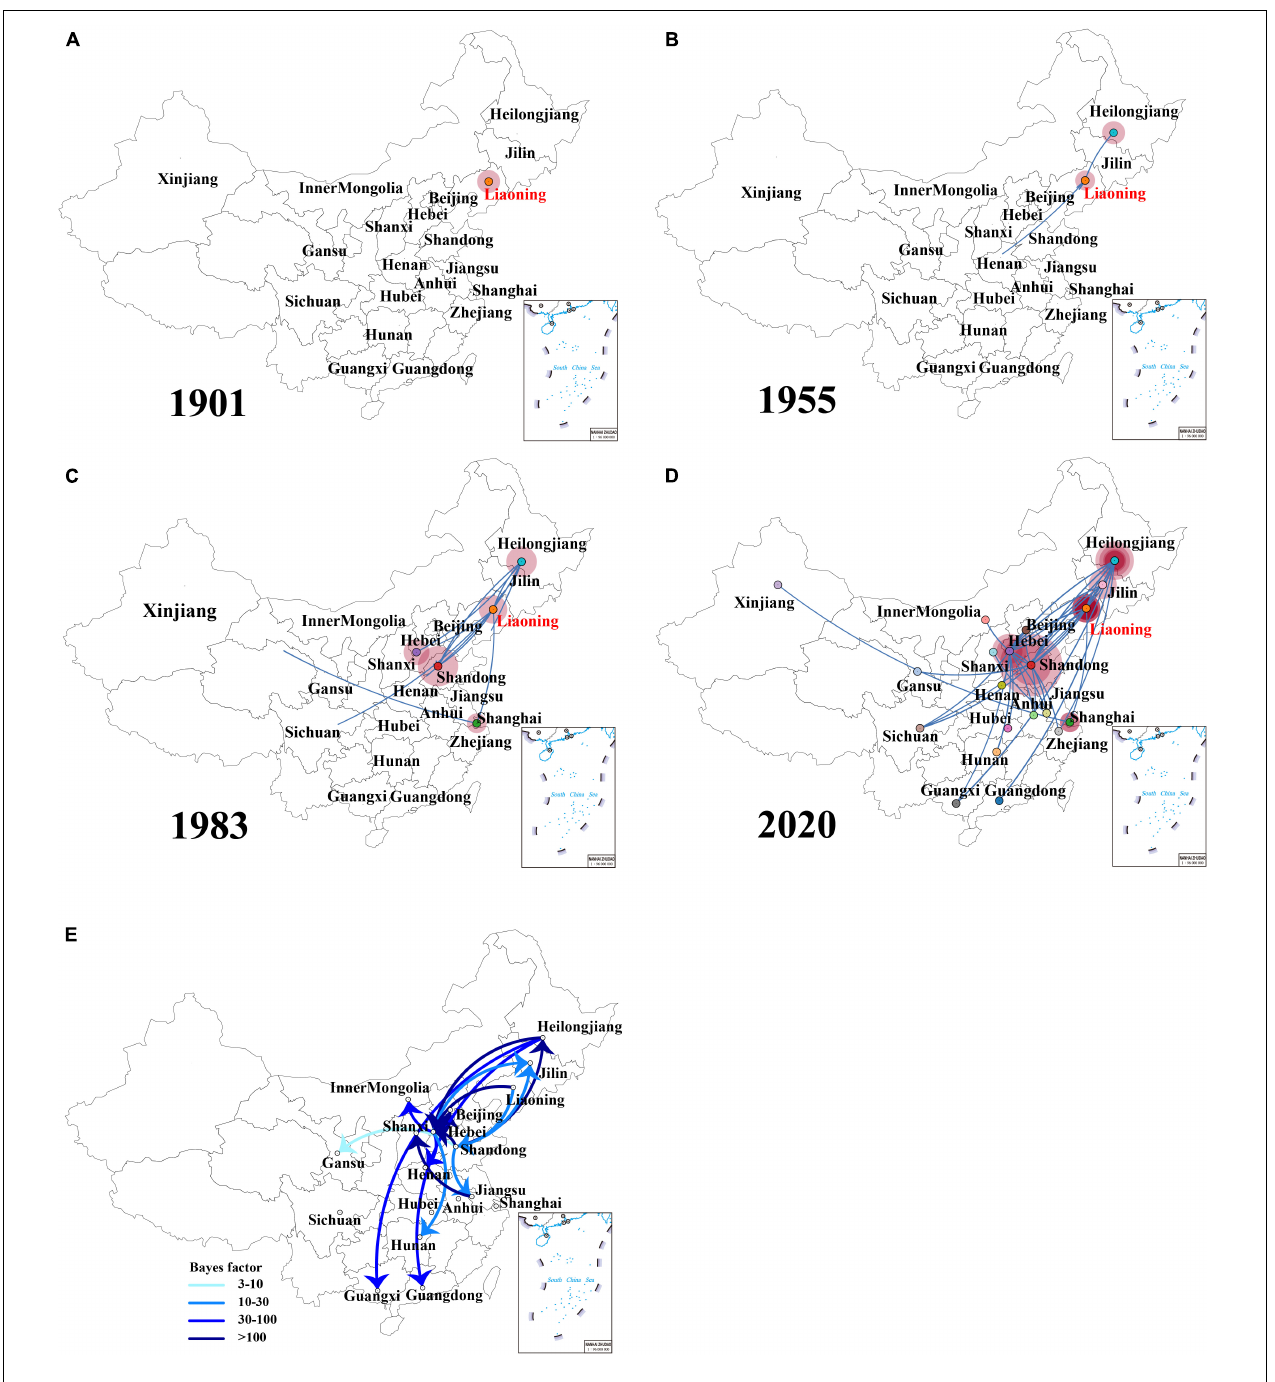
FIGURE 4 | The dynamics analysis of geographical regions of the full-length genome sequences of field isolates from China sampled during the years 1985–2020 (A–D) . Spatiotemporal dynamics of the full-length genome gene sequences of infectious bronchitis virus (IBV) among 20 localities. Bayes factor (BF) test for significant non-zero rates and regional transmission analysis (E) . Curves show the among-country virus lineage transitions statistically supported with Bayes factor > 3 for all the IBV isolates in China. Curve colors represent corresponding statistical support (Bayes factor value) for each transition rate (inset).